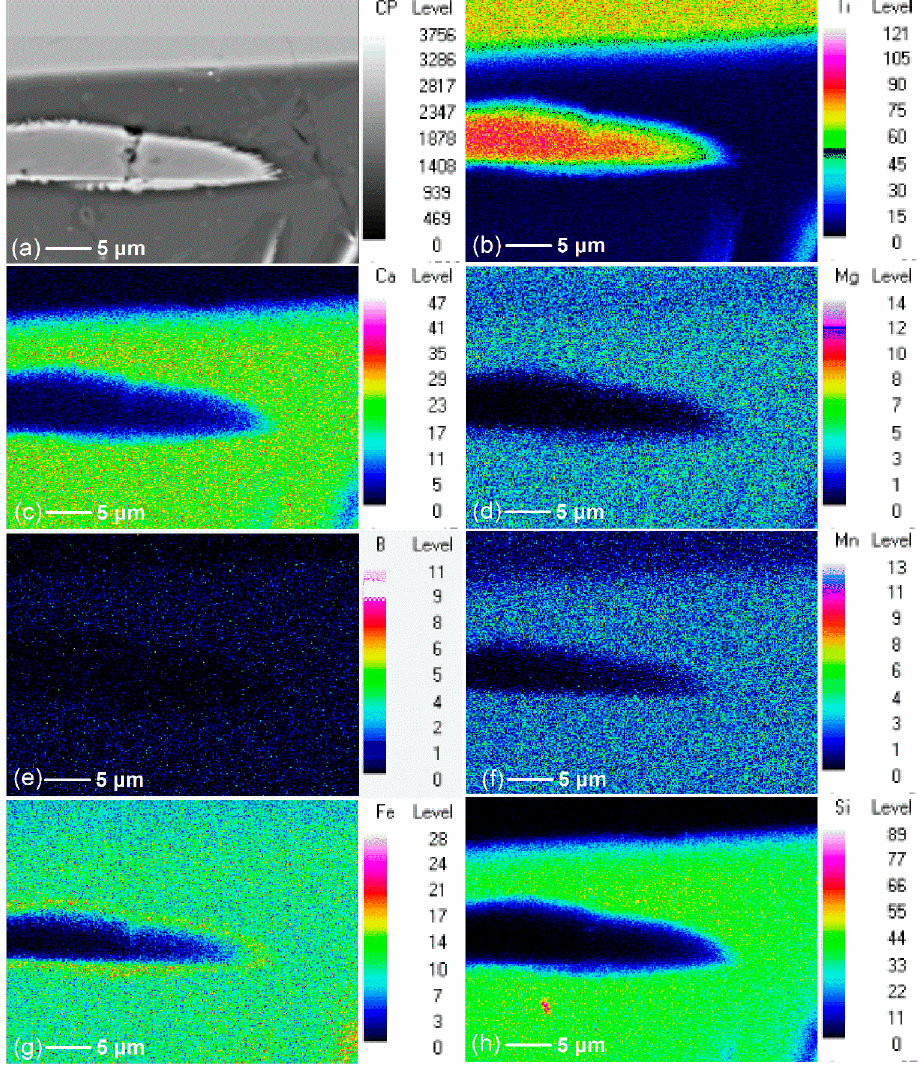
Figure 5. WDS mapping analysis of the cross-section of block sample of the modified titanium slag with the additive (B 2 O 3 ) amount of 4%: ( a ) total, ( b ) Ti, ( c ) Ca, ( d ) Mg, ( e ) B, ( f ) Mn, ( g ) Fe, and ( h ) Si.